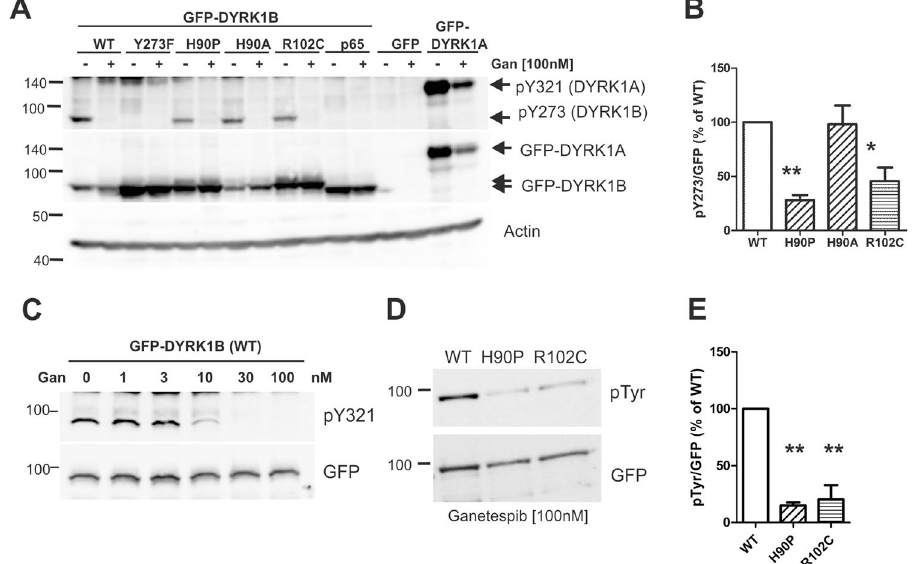
Figure 4. Effect of ganetespib on wild type and mutant DYRK1B. ( A , B , C ) Analysis of total cellular lysates. GFP- DYRK1B constructs were transiently expressed in HeLa cells as indicated. Cells were treated with ganetespib (100 nM) for 24 h before denaturing SDS lysis. Total cellular lysates were analysed for the phosphorylation of the activation loop tyrosine (Y273 in DYRK1B, Y321 in DYRK1A) using an antibody originally designed against the activation loop tyrosine in HIPK2. Actin was detected to control for equal loading. Panel A shows a the Western blots of a representative experiment, and panel B presents the quantification of the pY273 signal in the untreated cells relative to the GFP signal (means and SD; n = 3). In panel C, HeLa cells expressing wild type GFP-DYRK1B were treated with increasing concentrations of ganetespib for 24 h. ( D , E ) Analysis of immunoprecipitates HeLa cells were treated with ganetespib for 16 h and extracted using the non-denaturing lysis buffer with Igepal CA- 630. GFP-DYRK1B constructs were immunoprecipitated and subjected to immunoblot analysis ( D ). Panel E illustrates the quantitative results of 3 independent experiments (means and SD). Significant differences between WT and mutant DYRK1B are marked (One sample t-test, * p < 0.05, ** p < 0.01).